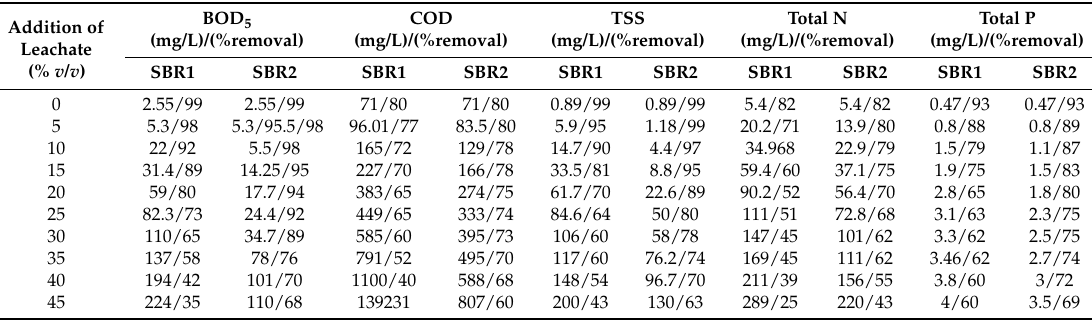
Table 11. Characteristics of effluents (the highlighted text indicates the limit value given by Polish legislation; the values marked grey and blue are for the control reactor and reactors fed with mixtures with pretreated leachate,